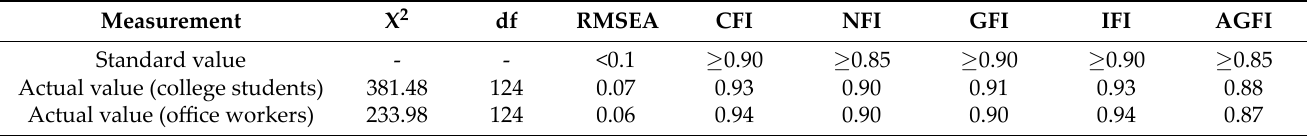
Table 4. Structural fitting test results.